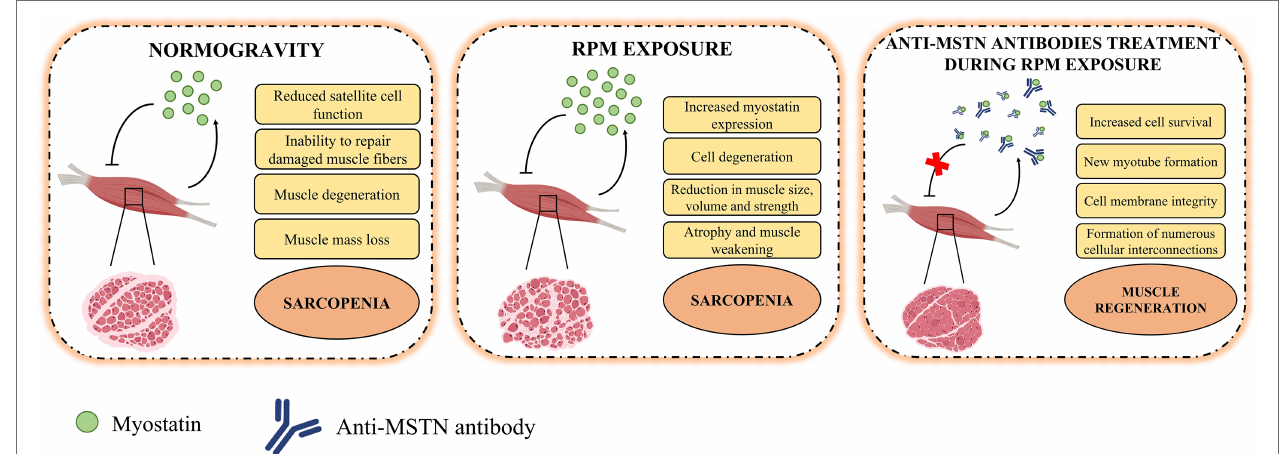
FIGURE 4 | Role of myostatin in the pathophysiology of muscle tissue. In normogravity, myostatin is produced by skeletal muscle on which it acts as a negative regulator, reducing satellite cell function and their ability to repair damaged muscle fibers, inducing degeneration and muscle mass loss, and so promoting the progression of sarcopenia. After RPM exposure, the increases myostatin expression caused cell degeneration and reduction in muscle size, volume, and strength. These conditions amplified atrophy and muscle weakening and accelerated the sarcopenia progression. The anti-MSTN antibodies treatment blocks the action of myostatin and promote an increase in cell survival, the formation of new myotubes and muscle